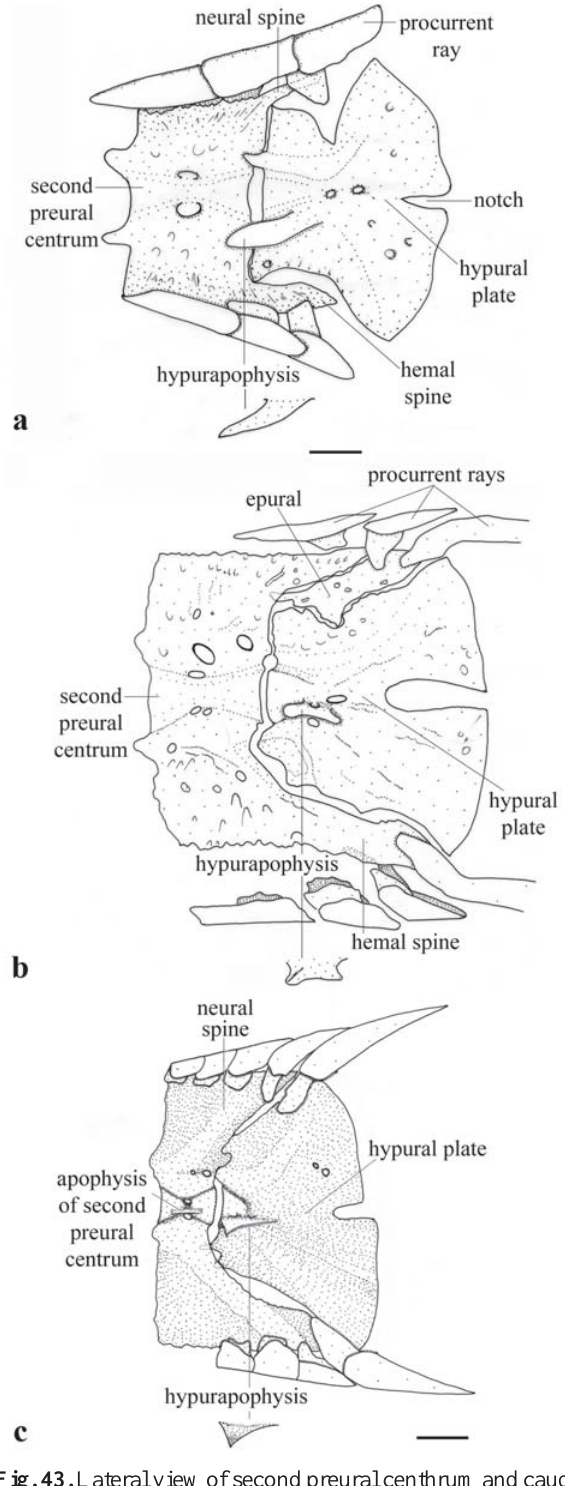
Fig. 43. Lateral view of second preural centhrum and caudal- fin skeleton (right side) of Harttia loricariformis (MZUSP 66187, 67.7 mm SL) (a, scale bar = 0.5 mm), Neoplecostomus ribeirensis (MZUSP 100920, 45.3 mm SL) (b, scale bar = 0.5 mm), and Hypostomus sp. (MZUSP 100921, 58.7 mm SL) (c scale bar = 1 mm). Detail of each illustration show dorsal view of